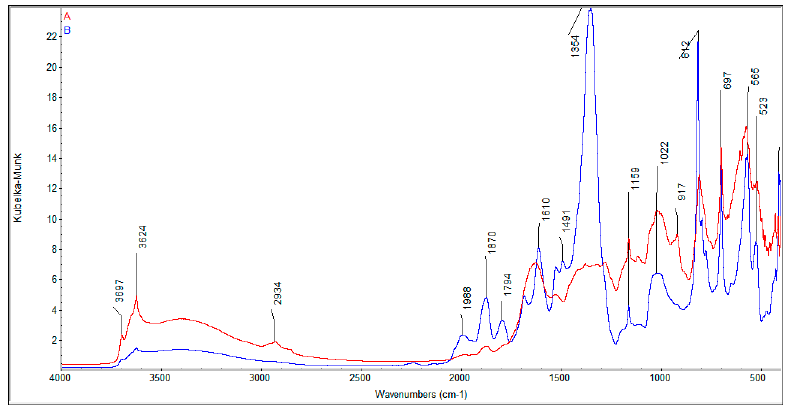
Figure 3. Exemplary soil spectra measured using the diffuse reflectance (DRIFT) technique in the mid infrared (MIR) region.